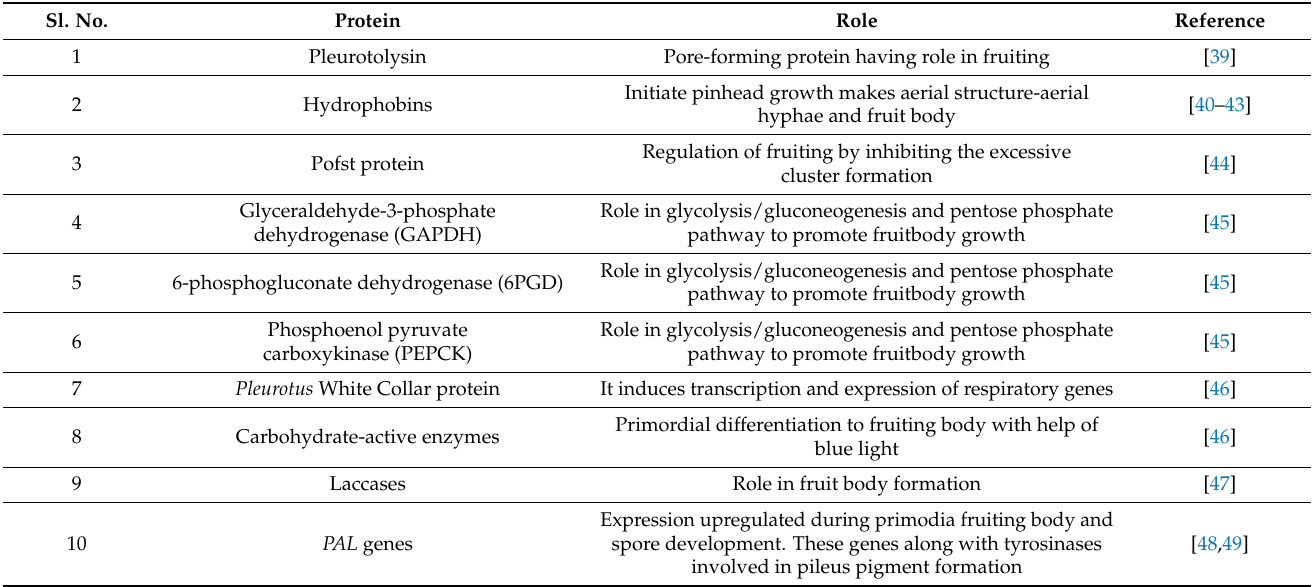
Figure 7. Module style view of fruiting mechanism pathway network node with physical simulation and catalysis. Table 2. Role of genes and protein in Pleurotus fruit body formation and development.